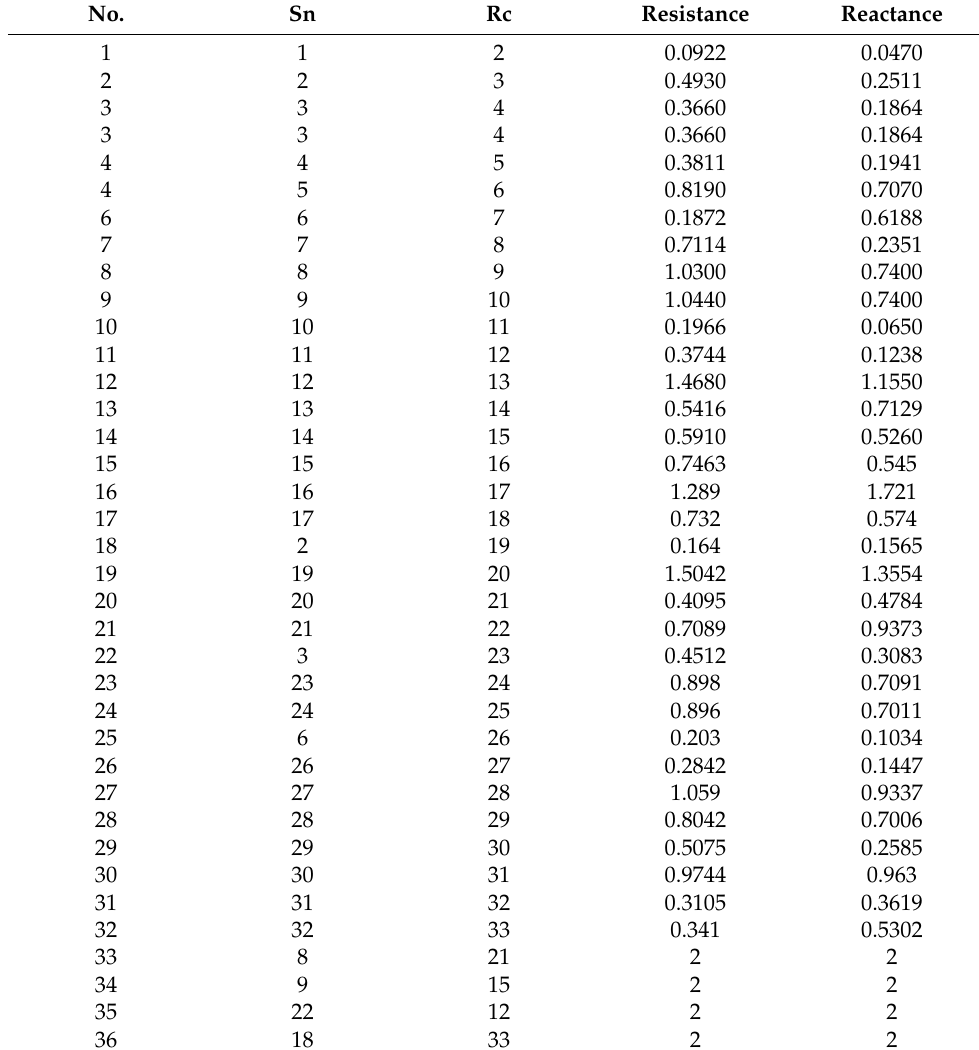
Table A1. IEEE 33 Bus Data.